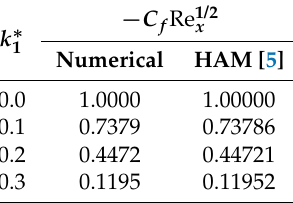
Figure 12. Variations of concentration rate for heterogeneous-reaction strength when K = 0.2, Sc b = 1.0 and M = 0.2. Table 2. Comparative data of skin-friction coefficient for various estimations of viscoelastic parameter when M =